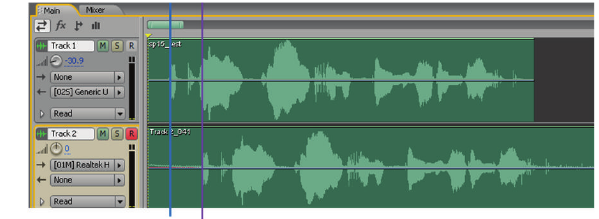
Figure 7: Adobe Audition player.